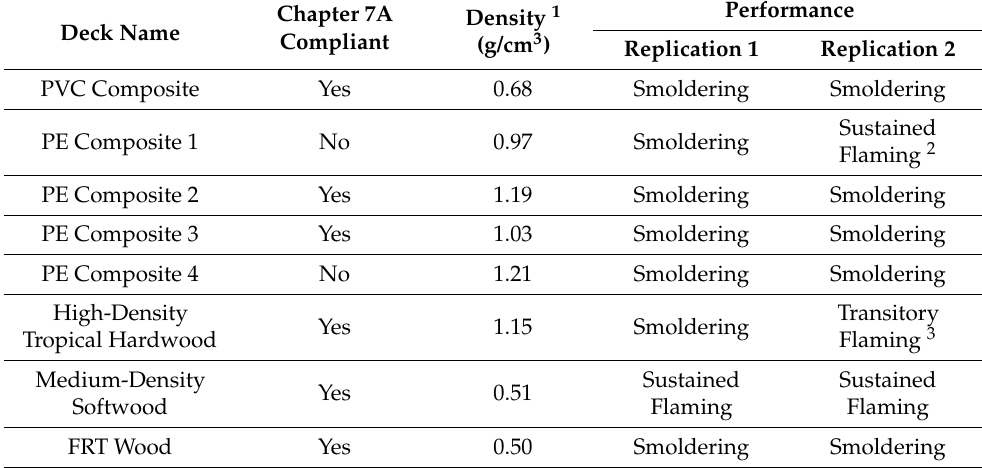
Table 1. Summary of the above-deck ember exposure